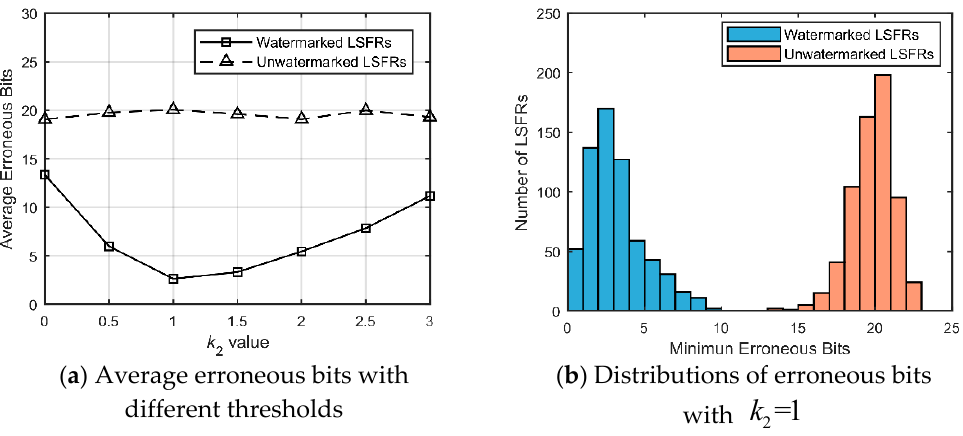
Figure 12. Erroneous bits corresponding to different message extraction thresholds.